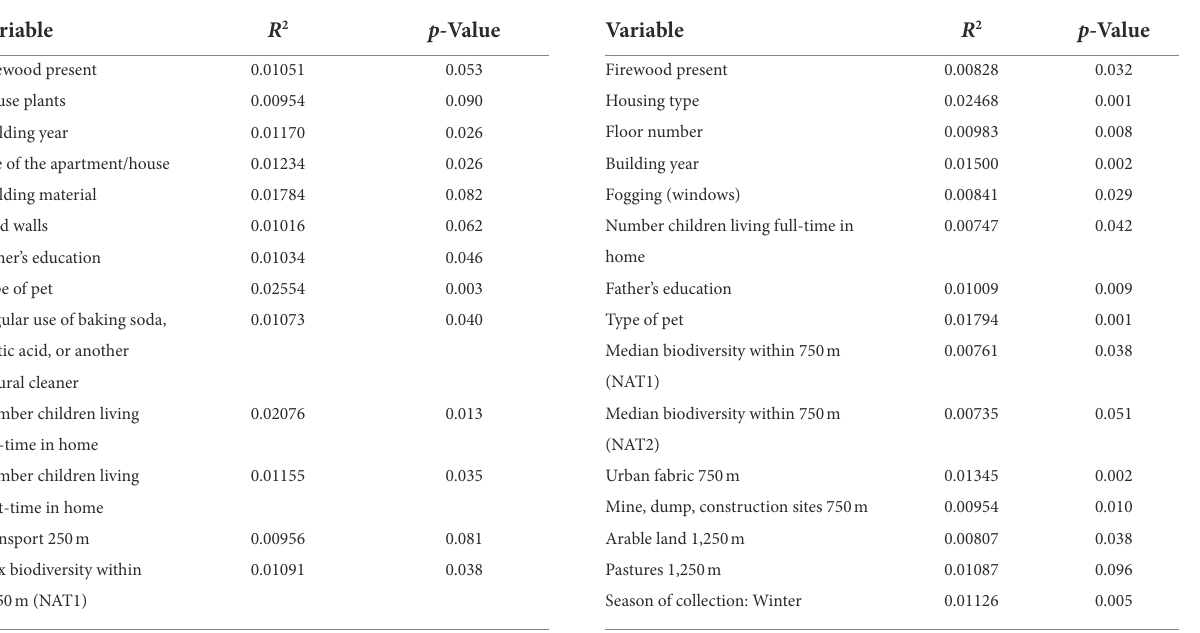
Figure 2D), but the number of cats was not ( p = 0.224). The relationship between the number of dogs and fungal genera (Figures 2E,F) was divided between the phyla Ascomycota and Basidiomycota. There was a trend of increasing relative abundance of Ascomycota families, specifically Didymellaceae ( p = 0.001; estimate: 0.59), with a corresponding decrease in Basidiomycota, such as Filobasidiaceae ( p = 0.001; estimate: − 0.60) and Peniophoraceae ( p = 0.006; estimate: − 0.52), with increasing